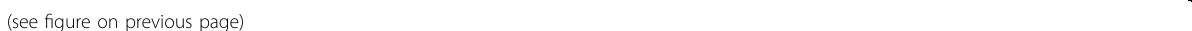
Fig. 2 Notch3 inhibits the AKT-mTOR pathway by binding to the CSL element of the PTEN promoter. Notch3ICD overexpression increased PTEN and p27 expression in MDA-MB-231 cells but inhibited the protein ( a ) and mRNA ( b ) expression levels of AKT-mTOR-Cyclin D1 pathway components. Notch3 knockdown inhibited PTEN and p27 expression in MCF-7 cells but induced the protein ( c ) and mRNA ( d ) expression of AKT- mTOR-Cyclin D1pathway components. e Schematic diagram of the PTEN promoter regions ampli fi ed by different primer sets in the ChIP assays. Regions 2 and 3 each contain a CSL-binding element. Region 1, which does not contain the CSL-binding element, was used as a negative control. f For the ChIP assays, Notch3-binding PCR products were detected in regions 2 and 3 using an anti-Notch3 antibody. g Notch3 was knocked down in MCF-7 cells by siRNA, which were co-transfected with a wild-type or mutant PTEN promoter-containing fi re fl y luciferase construct and pRL-SV40 as the control plasmid containing Renilla luciferase. The ratio of fi re fl y luciferase to Renilla luciferase values was used to determine promoter activity. Each sample was performed in triplicate. h N3ICD overexpression in MDA-MB-231 cells co-transfected with a wild-type or mutant PTEN promoter- containing Fire fl y luciferase construct and pRL-SV40 as the control plasmid containing Renilla luciferase. The ratio of Fire fl y luciferase to Renilla luciferase was used to determine the promoter activity. Each sample was performed in triplicate. * P < 0.05, ** P <